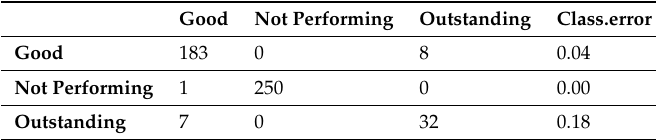
Table 6. Confusion matrix from Random